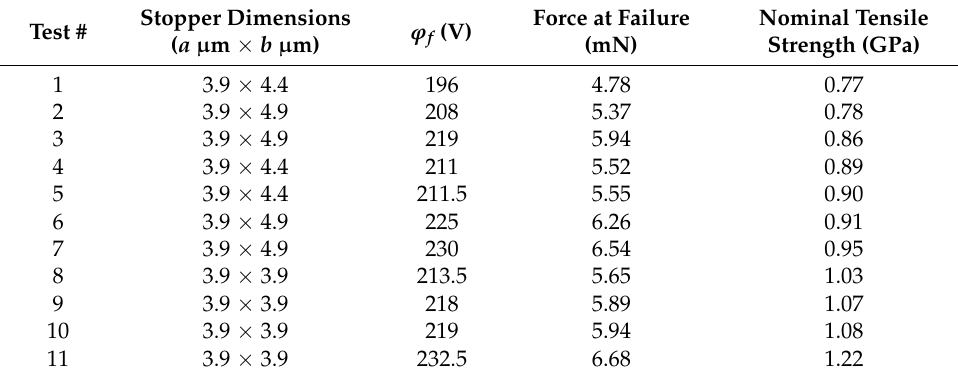
Table 1. Experimental results, in terms of applied voltage, applied force, and computed tensile strength. For each experiment, nominal stopper sizes are also